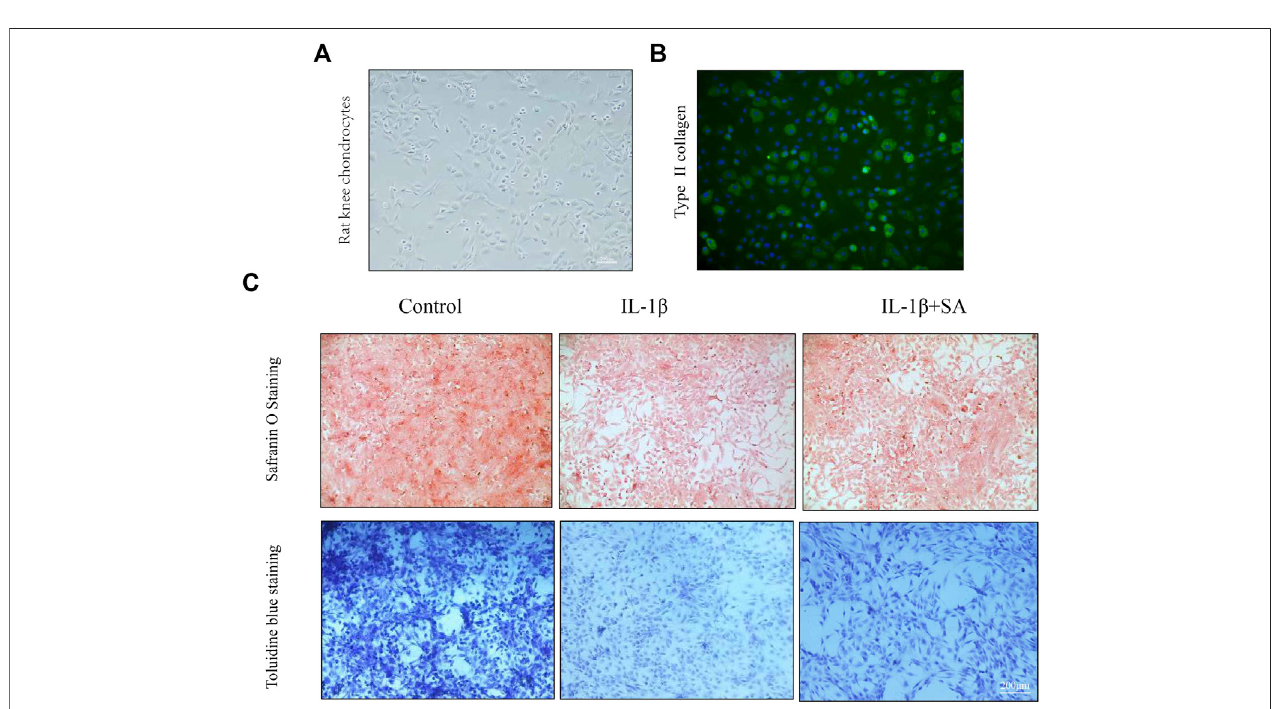
FIGURE 7 | SA mitigates cartilage degradation of ECM of rat knee chondrocytes in vitro . (A) Phase-contrast micrographs of rat knee chondrocytes plated on culture dishes. (B) Col 2 immuno fl uorescence staining of rat knee chondrocytes. (C) Safranin O and toluidine blue staining for proteoglycans deposition in each group.